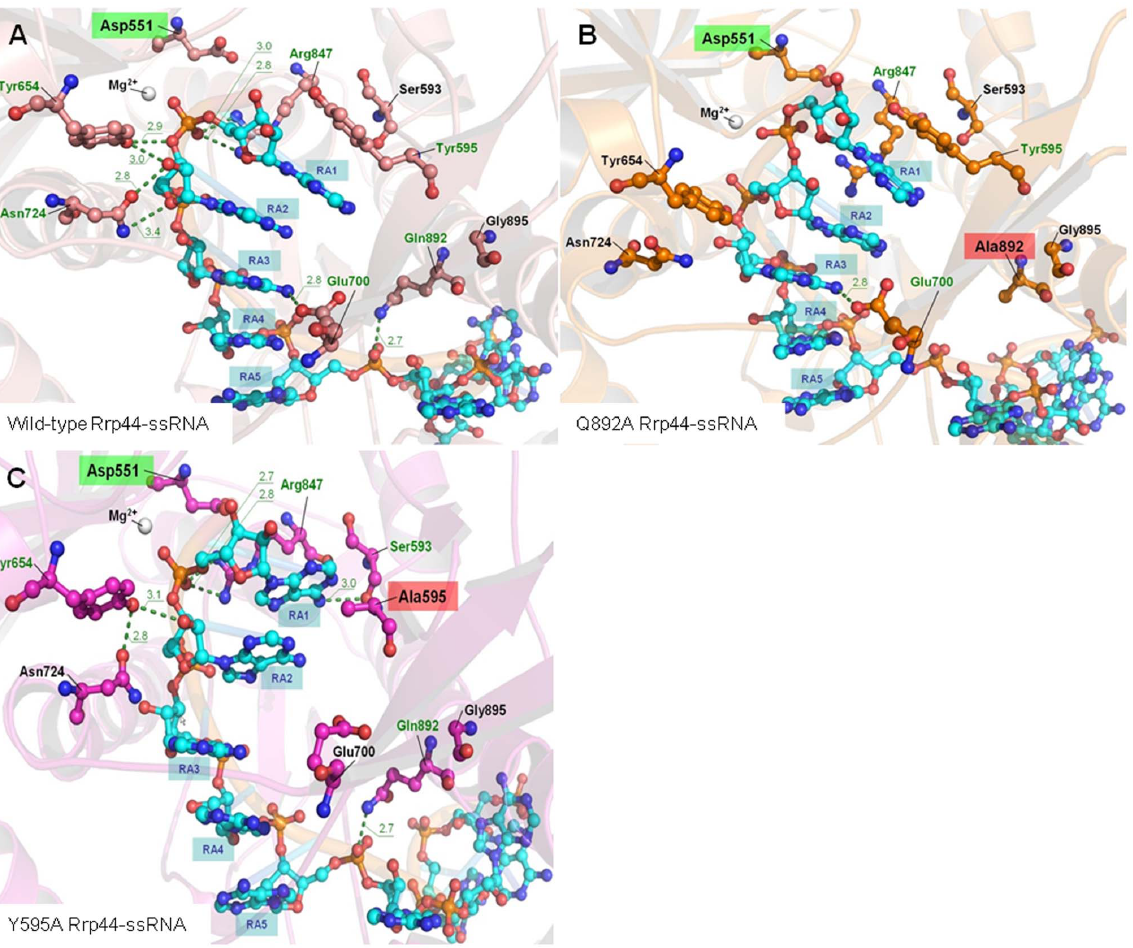
Figure 2. Theoretical catalytic site of Rrp44 RNB domain in S.cerevisiae . Wild-type (panel A) and mutants Q892A (panel B) and Y595A (panel C), in complex with one single strand poly(A) RNA molecule. Relative locations of some functionally relevant residues described in the text, depicted over every modeled protein’s 3D structure. Also layed out inside color text boxes, in silico reverted mutation Asp551 (green), Q892A and Y595A mutations (red), and nucleotide bases (blue) starting from RA1 (outgoing). Hypothetical hydrogen-bond mediated interactions, residue tags and annotations of corresponding point distances (in Angstroms, measured over every final representative model) depicted in green color. Other important residues, hypothetically invariant among modeled proteins, not shown for clarity.